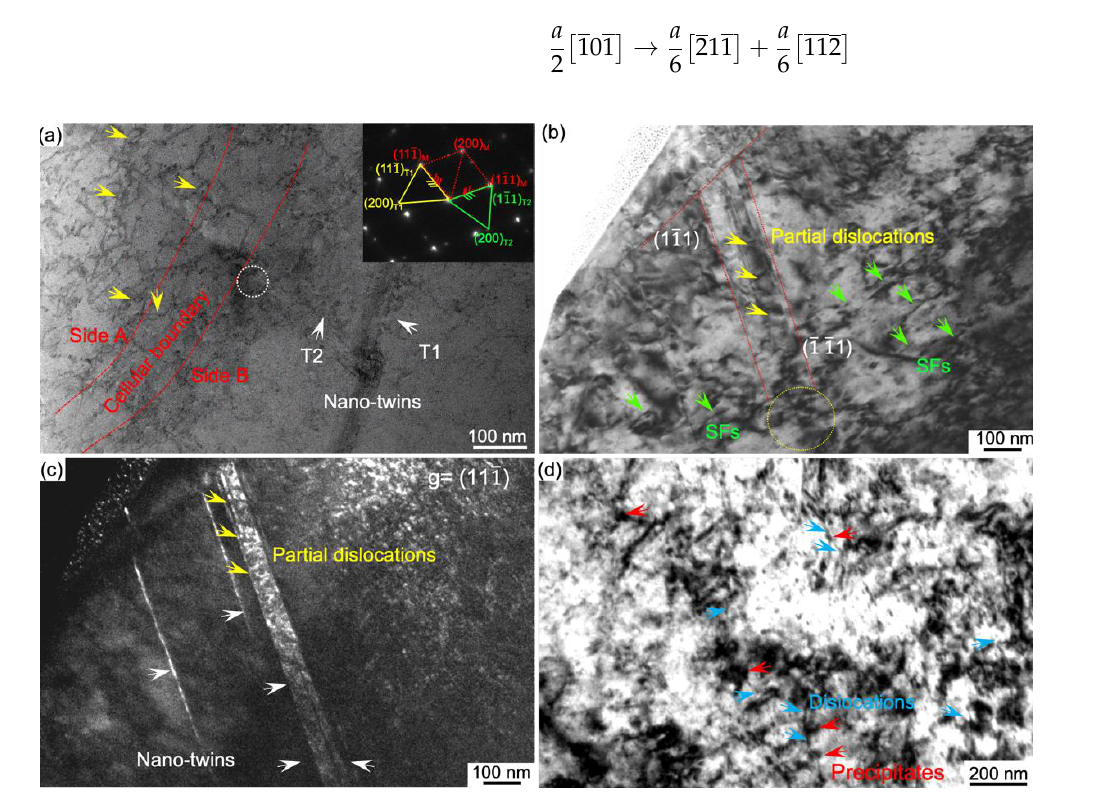
Figure 6. Post-mortem TEM observations. ( a ) BF-TEM image showing twin interactions with the MCS. Hierarchical nanotwins and the cellular boundary are indicated in white arrows and red lines respectively. The yellow arrows and the white circle indicate dislocation loops and dislocation piling up region respectively. ( b ) The BF-TEM image showing SFs (in green arrows) and partial dislocations (in yellow arrows). ( c ) The DF-TEM image taken with g = 111. ( d ) Precipitates in a MCS (marked as red arrows) are cut through by dislocations indicated as blue arrows.